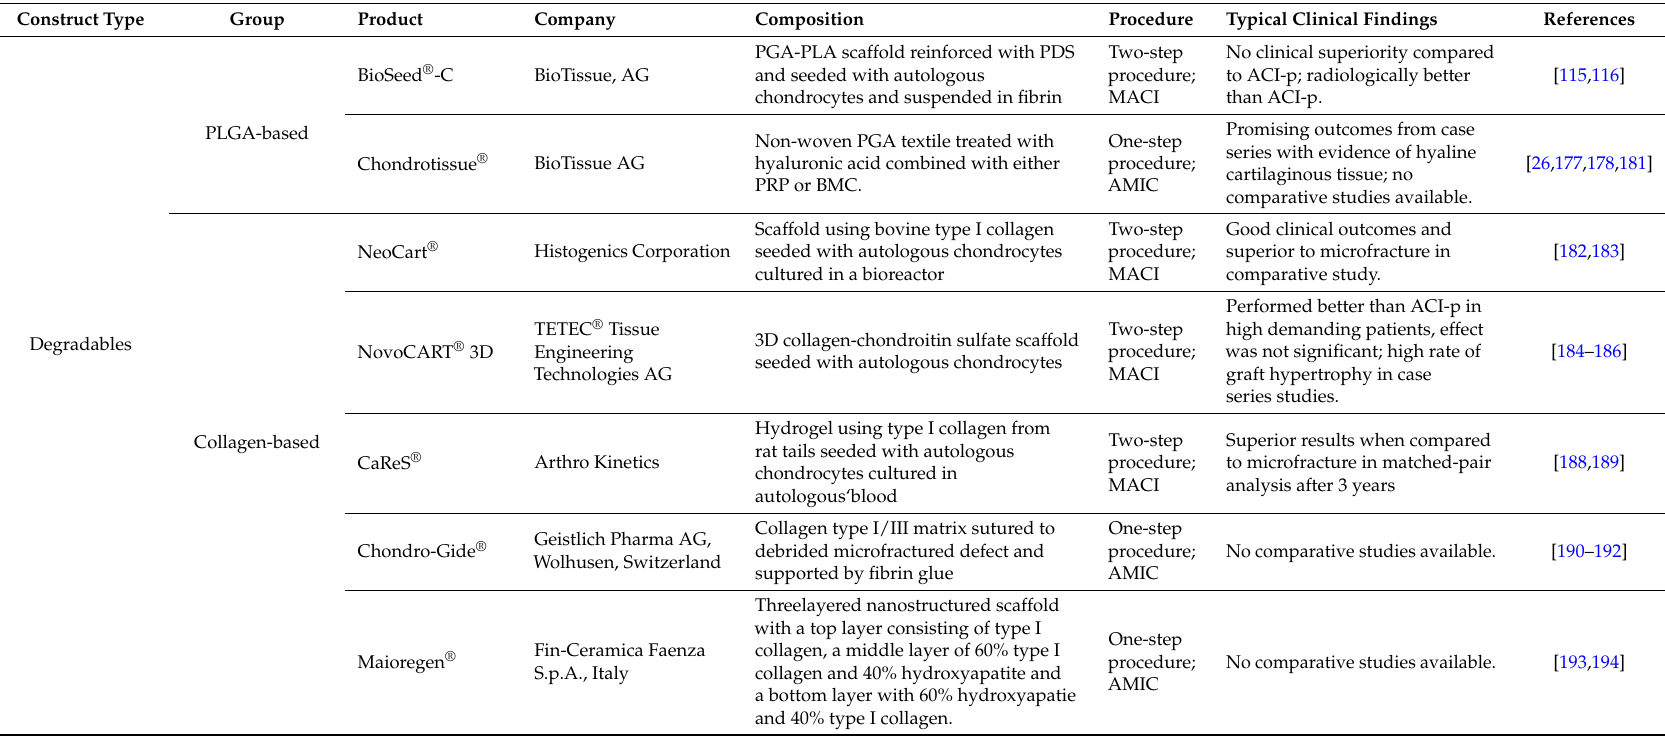
Table 2. Table 2 gives an overview of the commercially available products, their composition, the procedure type and typical clinical